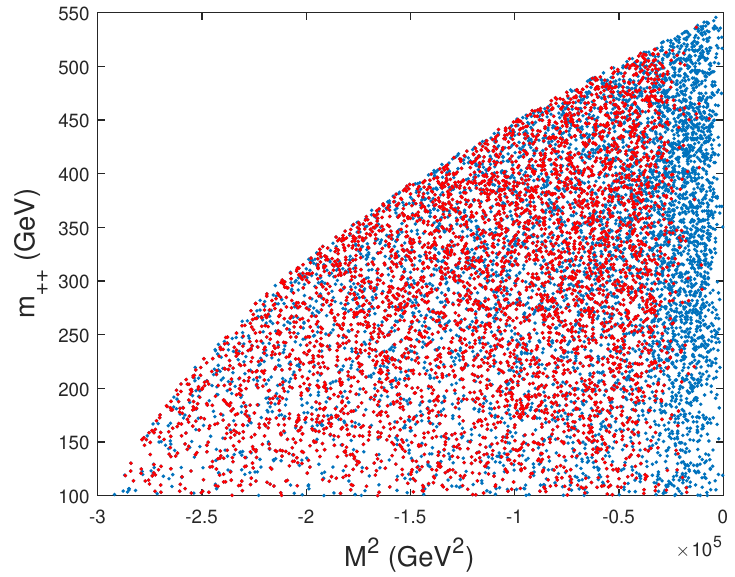
Figure 2 . Values of the doubly charged scalar mass a function of the quadratic coupling M 2 for a minimum of type N 1 in an HTM with softly broken global symmetry. In blue, all the scanned points; in red, those points for which there exists a CB vacuum (of types CB 7 or CB 10) lower than N